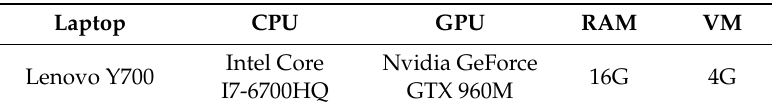
Table 6. The laptop configuration.